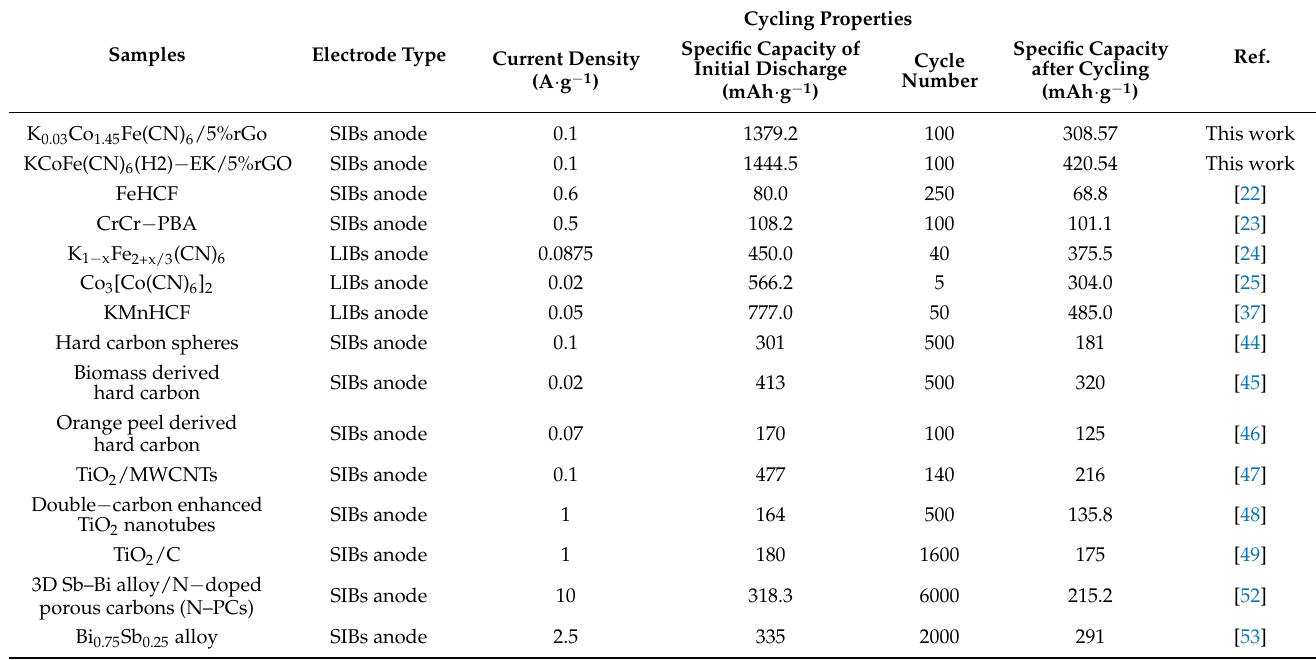
Table 2. Cycle stability of PBA anode